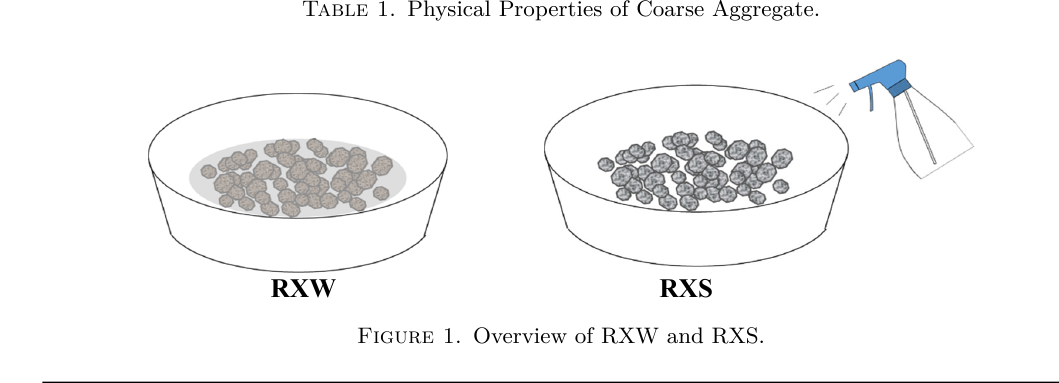
Table 1. Physical Properties of Coarse Aggregate.